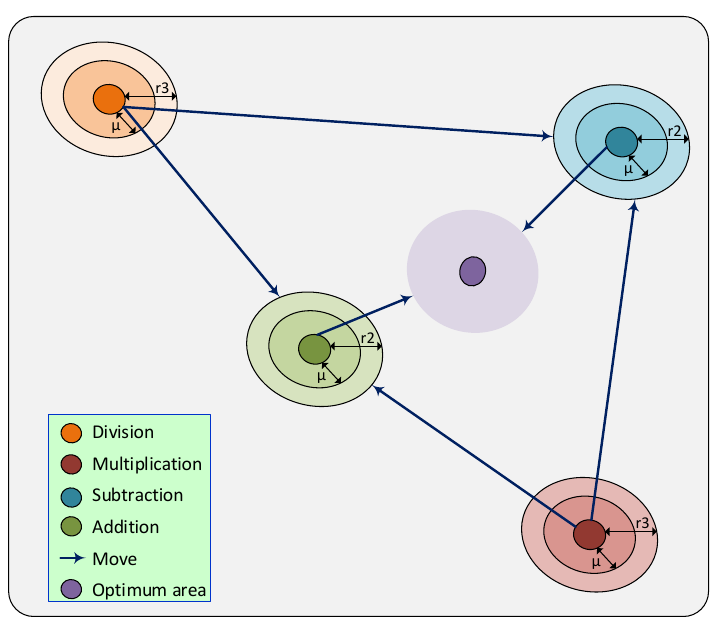
Figure 7. Model of updating the position of math operators in the original AOA algorithm towards the optimum area.